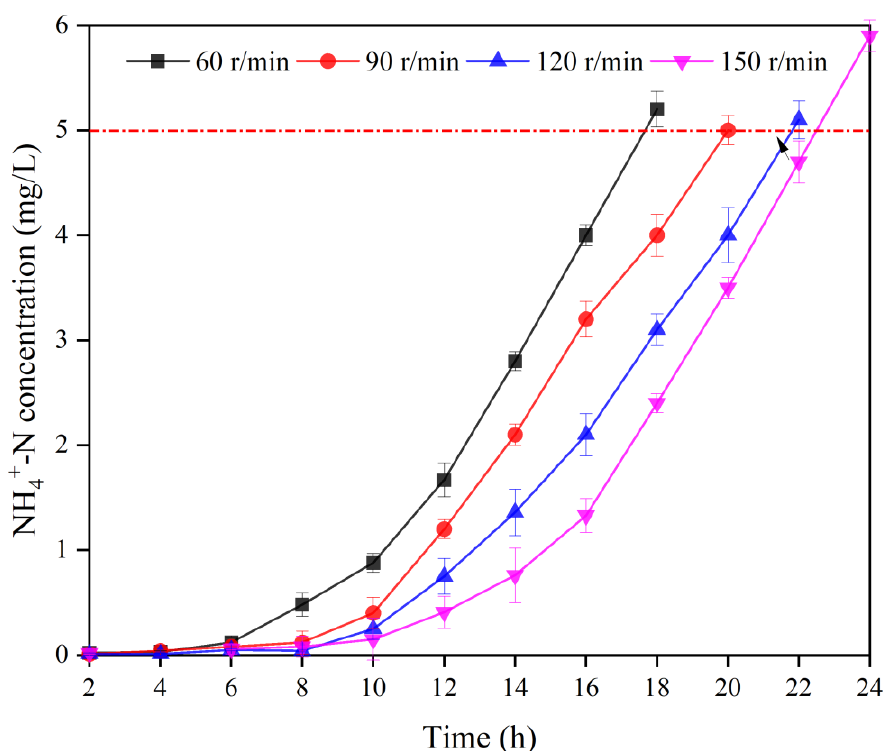
Figure 3. Breakthrough curves of MBBR with different stirring intensities. Vertical bars represent ± SD of the means ( n = 3).